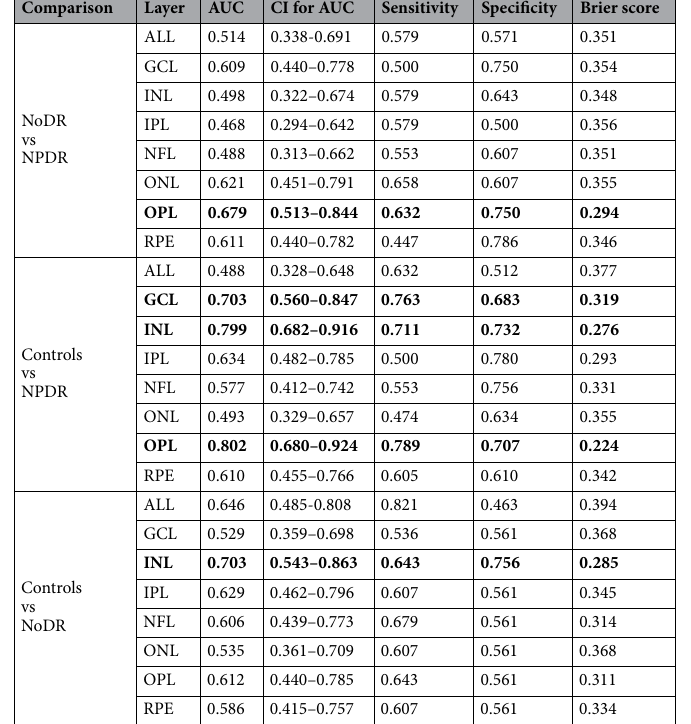
Table 2. Results of the predictive performance using density-based features as predictors for pairwise comparisons among controls, NoDR and NPDR based on seven retinal layers and overall retinal thickness. ALL stands for the overall thickness. The layers which are statistically significant in demonstrating discriminatory power for each pairwise comparison (lower bound for CI > 0.5) are shown in bold